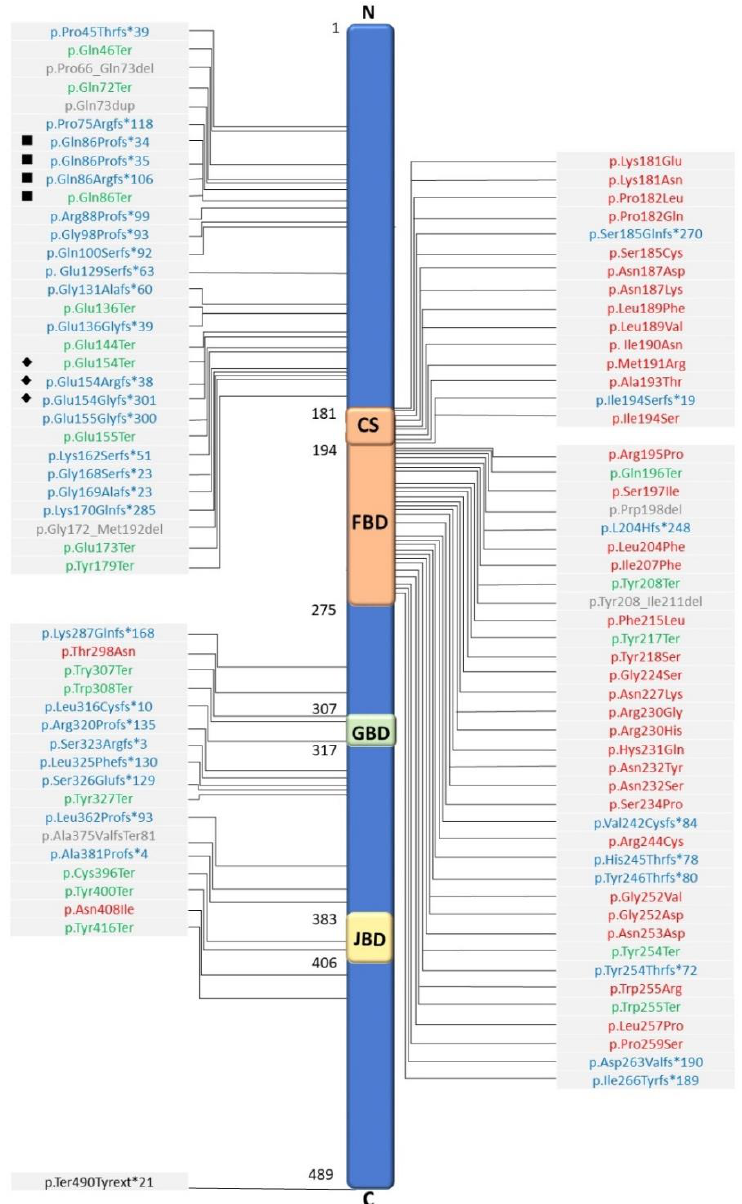
Figure 1. FOXG1 protein domains and distribution of variants. Published FOXG1 variants in a schematic illustration; the N-terminal domain, forkhead binding domain (FBD, amino acids 181-275), forkhead domain conserved site 1 (cs, amino acids 181-194), Groucho-binding domain (GTBD, amino acids 307–406), JARID1B-binding domain (JBD, amino acids 383–406), and C-terminal domain of FOXG1 protein are indicated. The published mutation variants include missense variants (red), frameshift (blue), nonsense (green), in-frame (gray), and stop loss (black) variants. The mutations are distributed in all protein domains. Most missense variants (red) cluster in the FBD, including cs, and are not found in the N-terminal domain. Frameshift variants (blue) are predominantly located in the N-terminal, while nonsense variants are found in all domains except the cs domain. Variants of two hot spot mutations are shown : ■ are variants of mutations at c.256, and ◆ are variants of mutations at c.460.